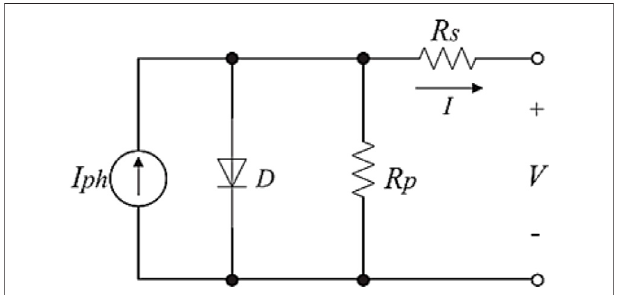
FIGURE 1 | The equivalent circuit of the one-diode model of a PV cell (Mokhtara et al., 2021).